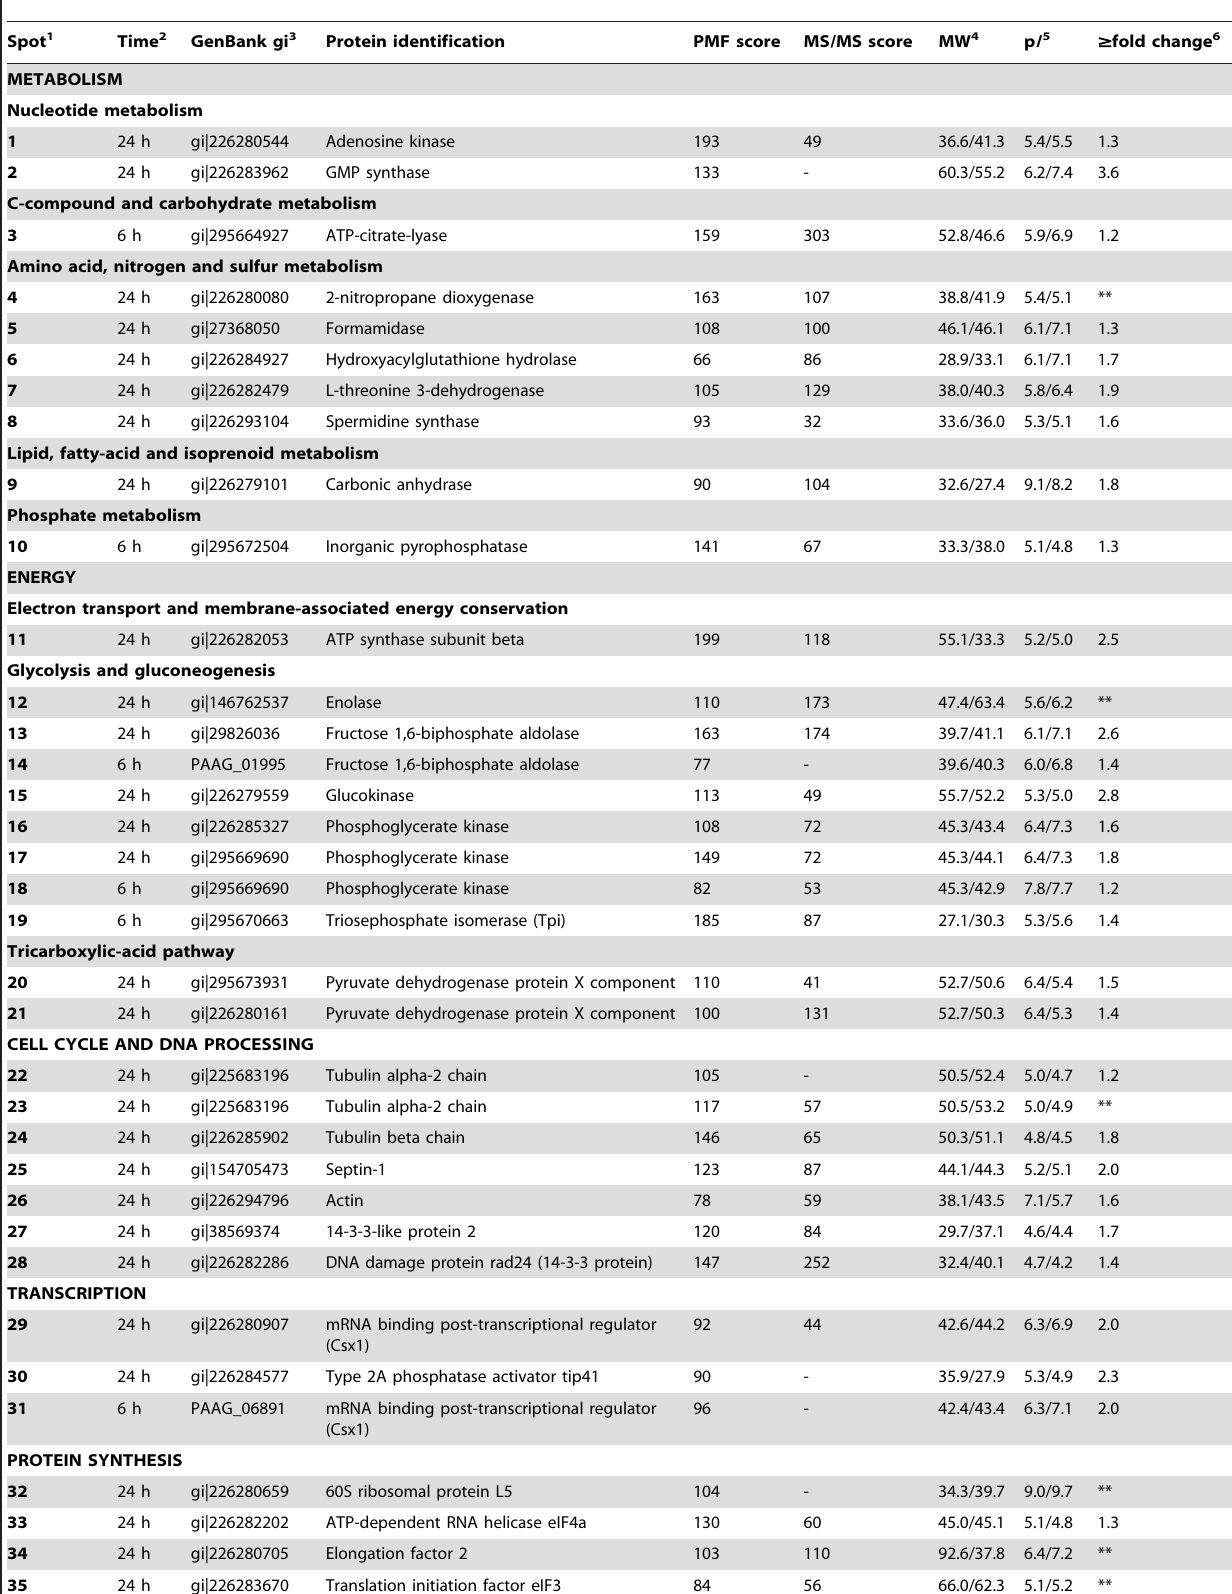
Table 1. P. brasiliensis identified proteins with increased expression during iron